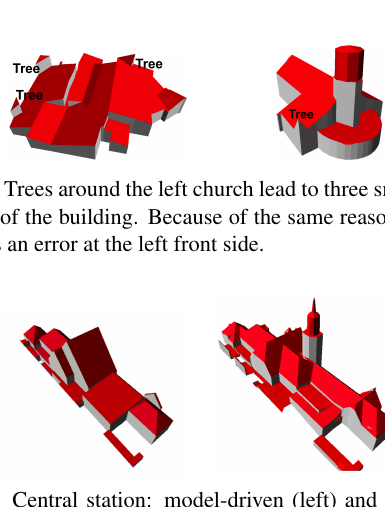
Figure 17: Central station: model-driven (left) and data-driven approach (right). In the model-driven approach, the tower was mistaken as a roof.